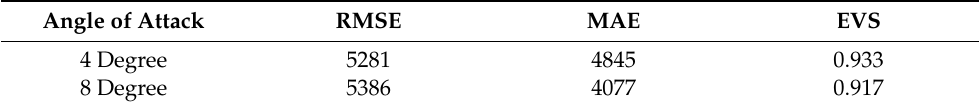
Figure 14. Variation of RMSE with number of estimators for GBR for 8° .